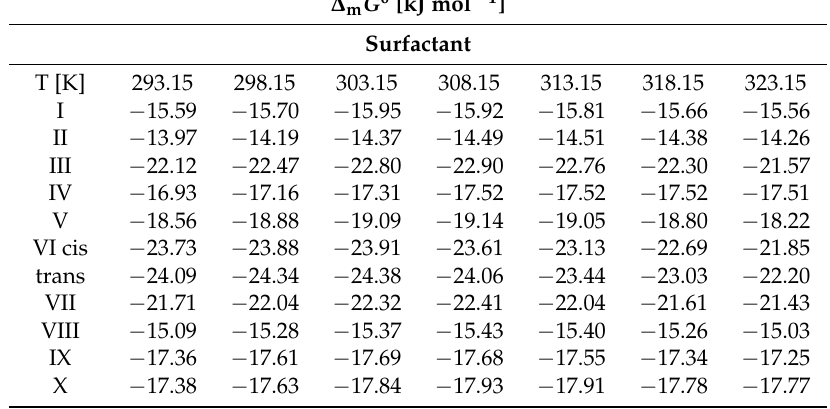
Table 6. Calculated values of standard molar Gibbs energy of micellization of all surfactants.